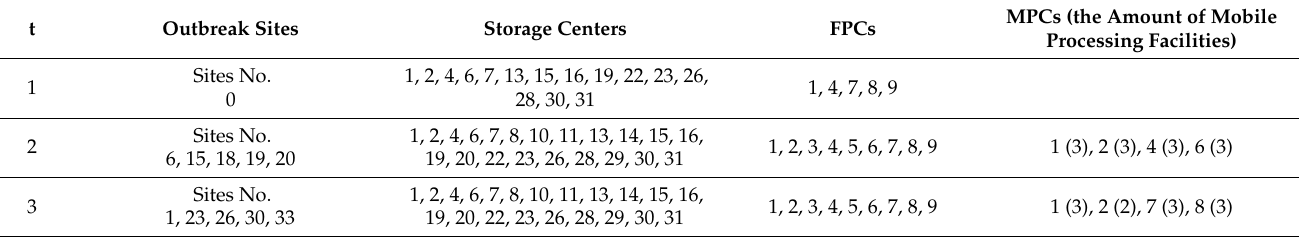
Table 5. Location